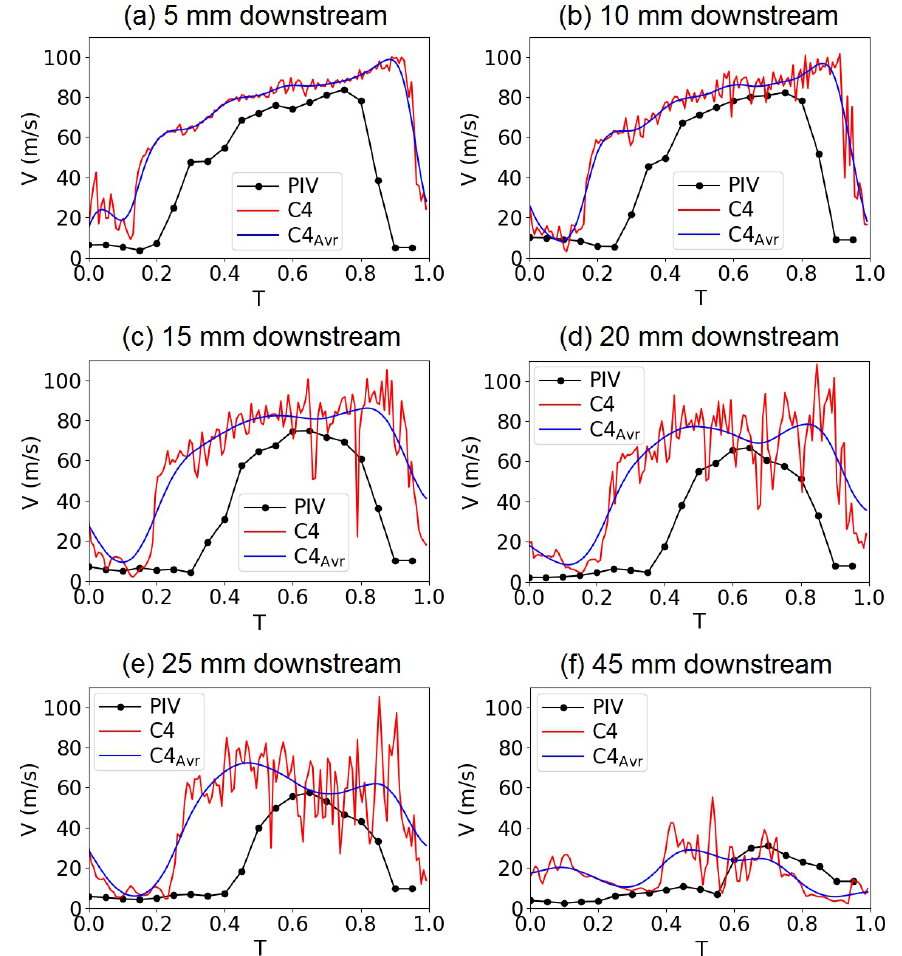
Figure 7. Time evolution of the magnitude of the velocity along the mid-axis of the supraglottal channel for an oscillation cycle. The velocity evolution of the computational model is related to one instantaneous cycle but the experimental velocity evolution is phase-averaged. The averaged velocity evolution of the computational model, smoothed by a low-pass filter (cutoff frequency = 5000 Hz), is added to the plots for the sake of better